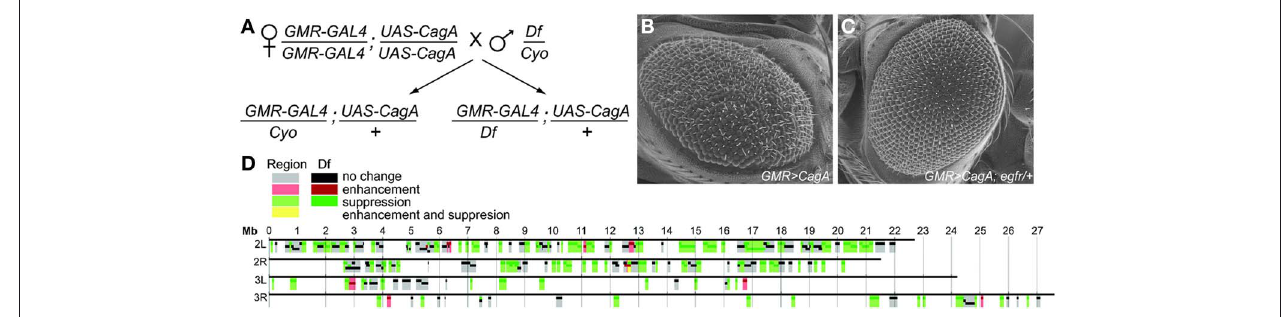
genetic deficiency screen. The result from each deficiency (darker colors) is indicated along with the inferred functionality of each genetic region (lighter colors), where deficiencies that caused no change override those that cause enhancement or suppression.